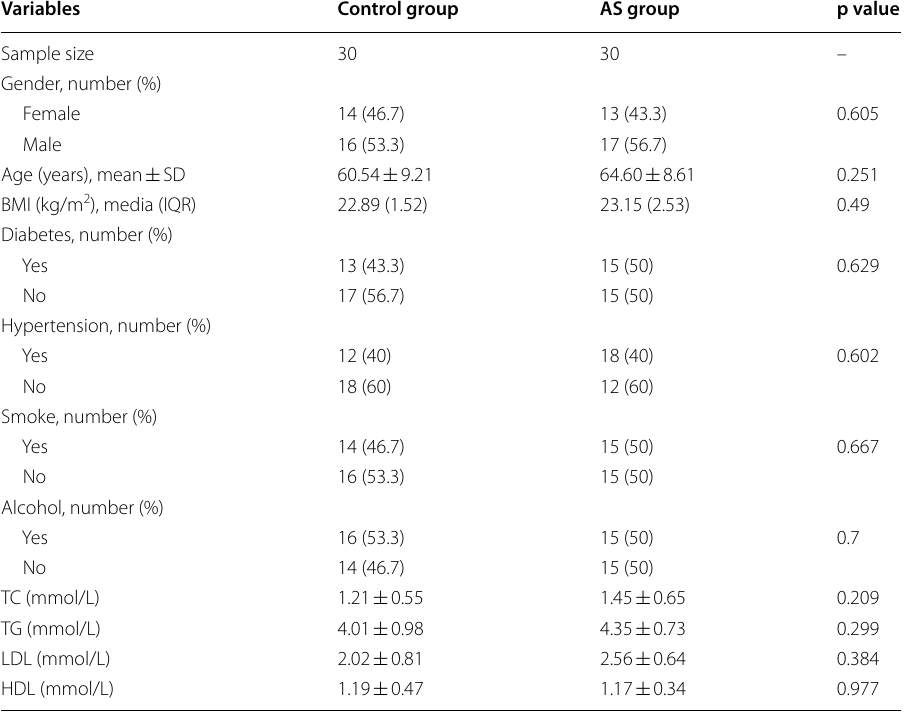
Data are presented as mean SD. Pearson χ 2 test. * P < 0.05 was considered statistically ±